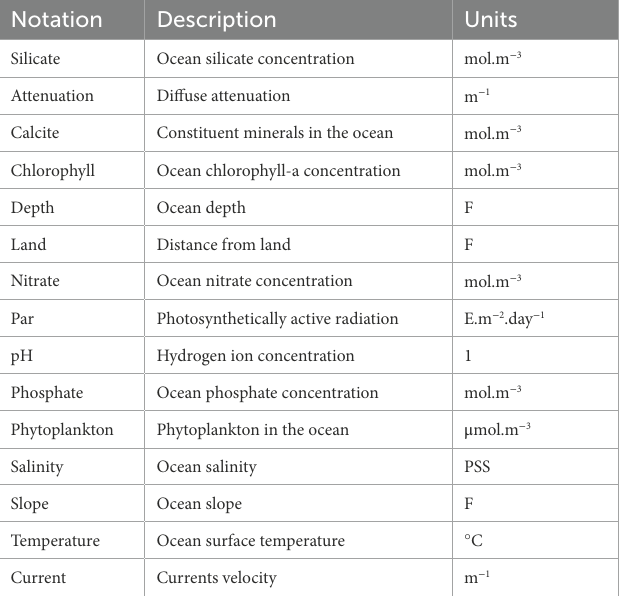
TABLE 1 Environmental variables used in this